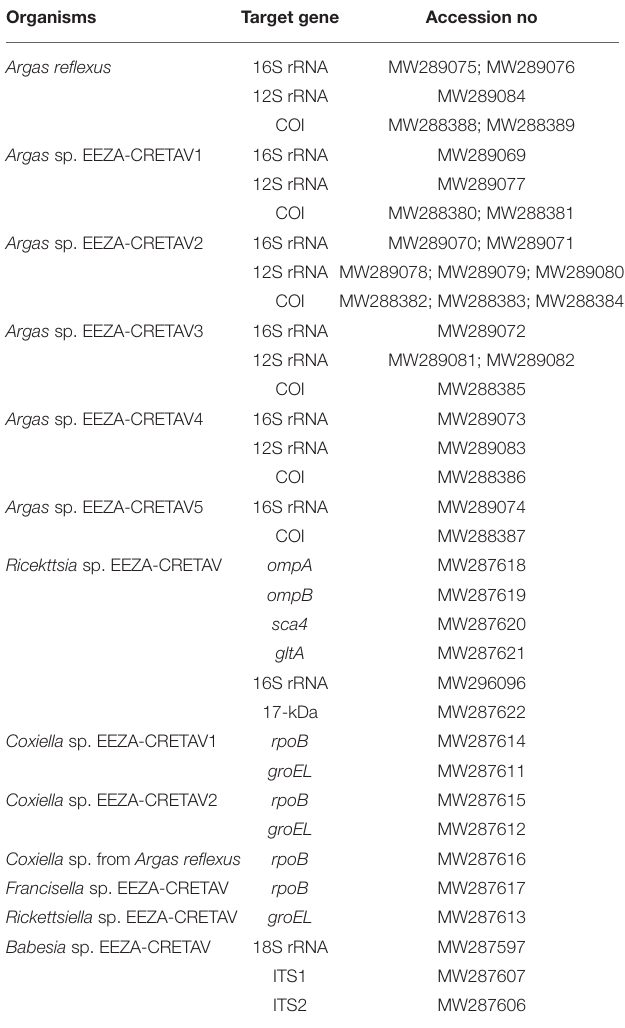
TABLE 6 | GenBank accession numbers of the nucleotide sequences obtained in this study, differing from published sequences.